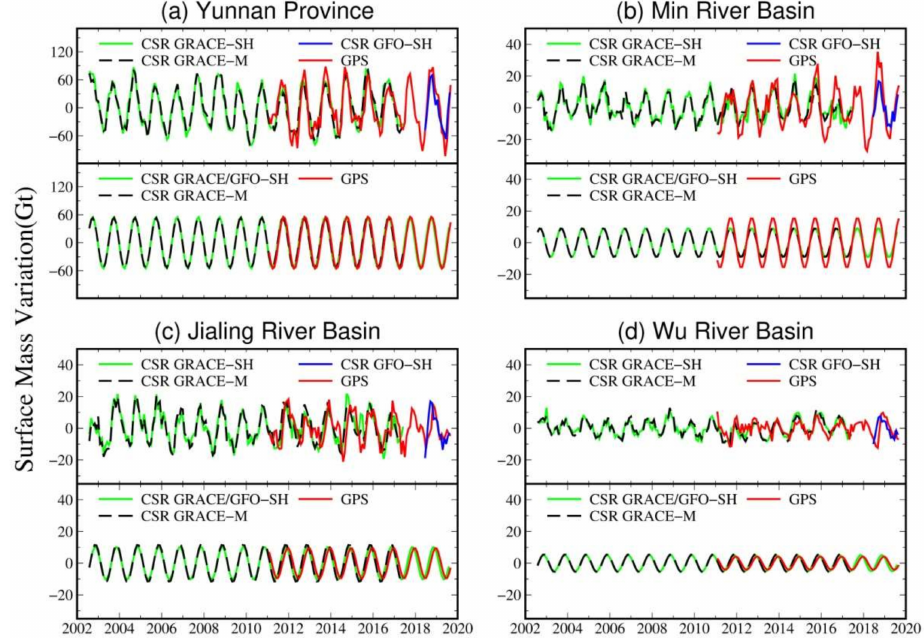
Figure 8. Surface mass change time series (top) and annual time series (bottom) for the ( a ) Yunnan Province (YNP), ( b ) Min River Basin (MRB), ( c ) Jialing River Basin (JLRB), and ( d ) Wu River Basin (WRB), respectively. The mass change time series are derived from GPS vertical displacements (GPS,fromJanuary2011toAugust2019), CSRRL06GRACESHsolutions(CSRGRACE-SH,fromAugust 2002 to June 2017), CSR RL06 GRACE mascon solutions (CSR GRACE-M, from August 2002 to June 2017), and CSR RL06 GFO SH solutions (CSR GFO-SH, from June 2018 to August 2019). The annual time series are fitted using CSR GRACE-SH plus CSR GFO-SH (CSR GRACE / GFO-SH), CSR GRACE-M, and GPS estimates,